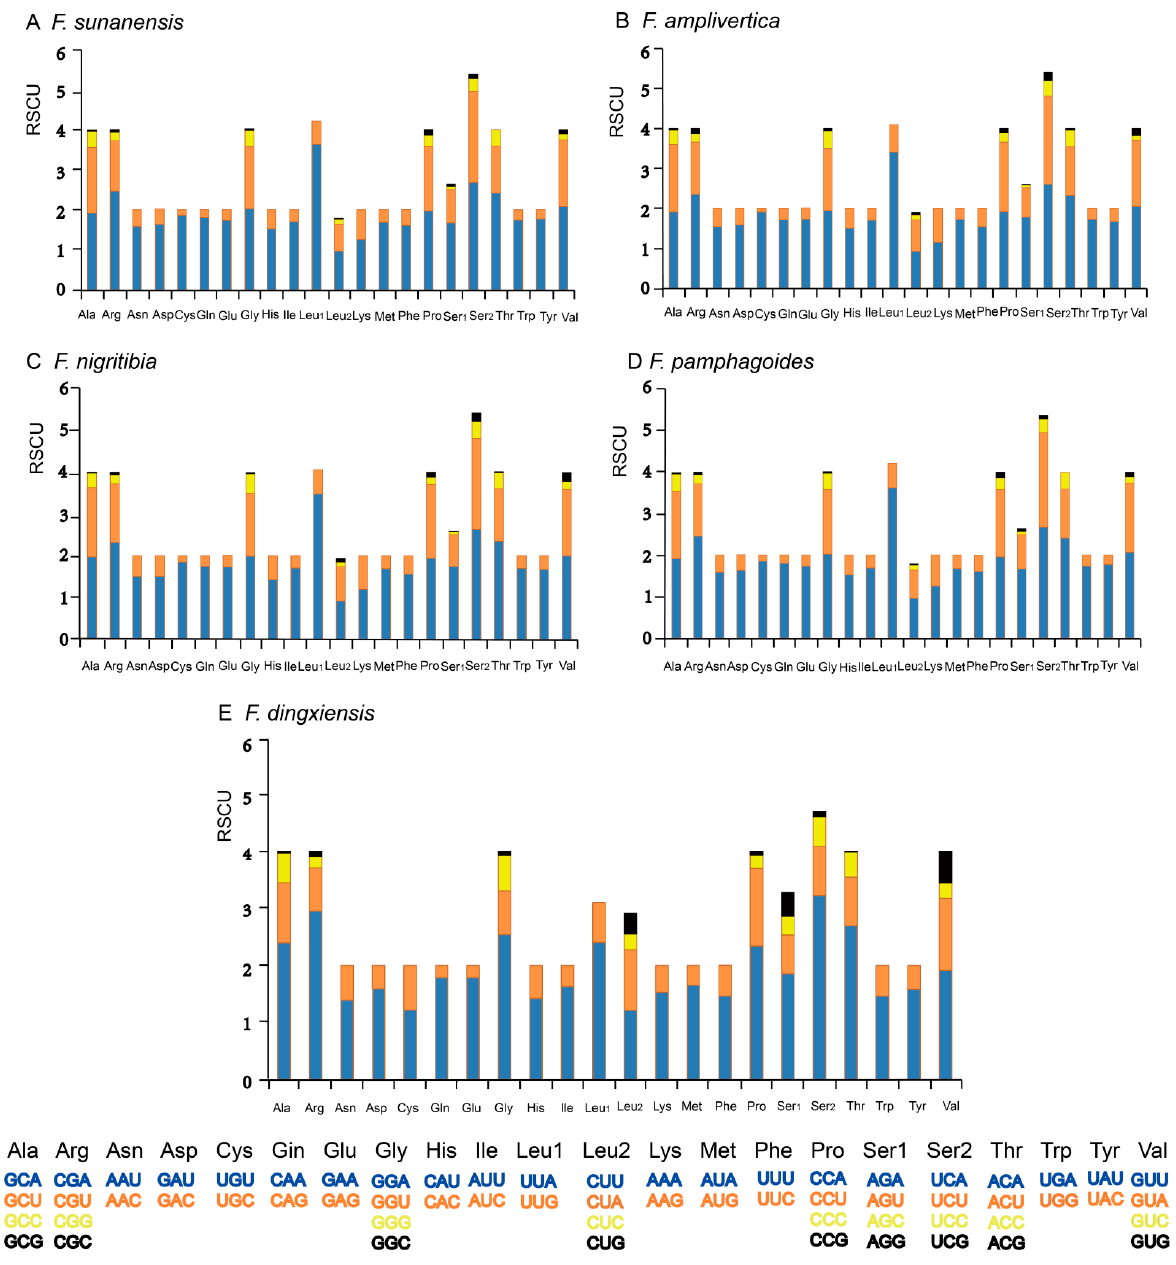
Figure 2. Relative synonymous codon usage (RSCU) of five grasshoppers of Filchnerella .